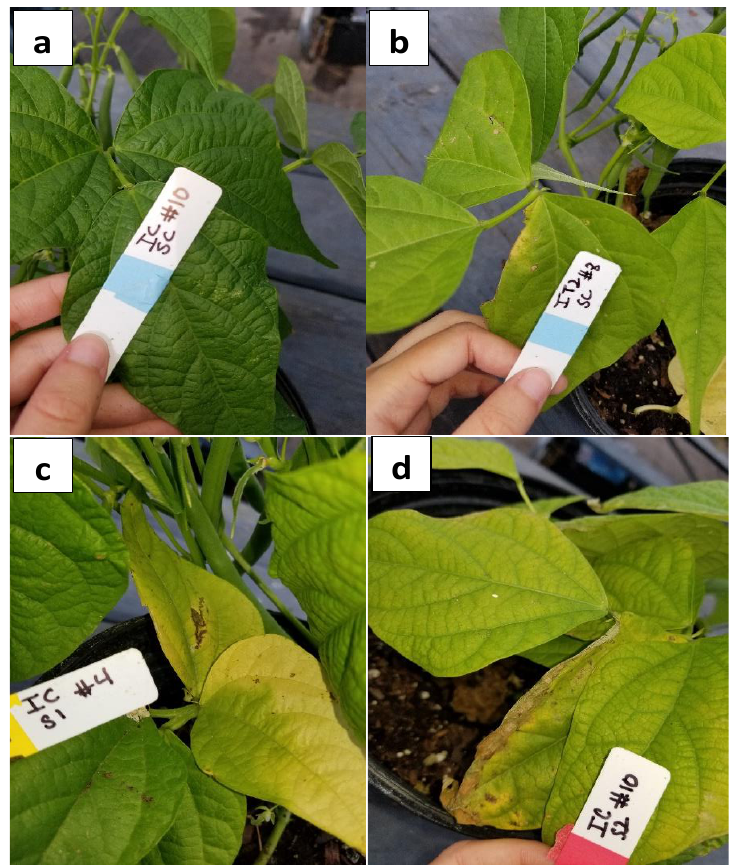
Figure 5. Visual representation of varying salinity effects on snap bean leaves prior to termination; ( a ) no impact, dark green color, ( b ) minor chlorosis effects on edges of leaves for non-stressed (0.6 dS m −1 ) co-inoculated beans, pale-green color, ( c ) moderate chlorosis on salt-stressed (1.0 dS m −1 ) non-inoculated snap beans, yellowish-green color, and ( d ) firing of the leaf margins on highly stressed (2.0 dS m −1 ) non-inoculated beans, straw-colored leaf margins.